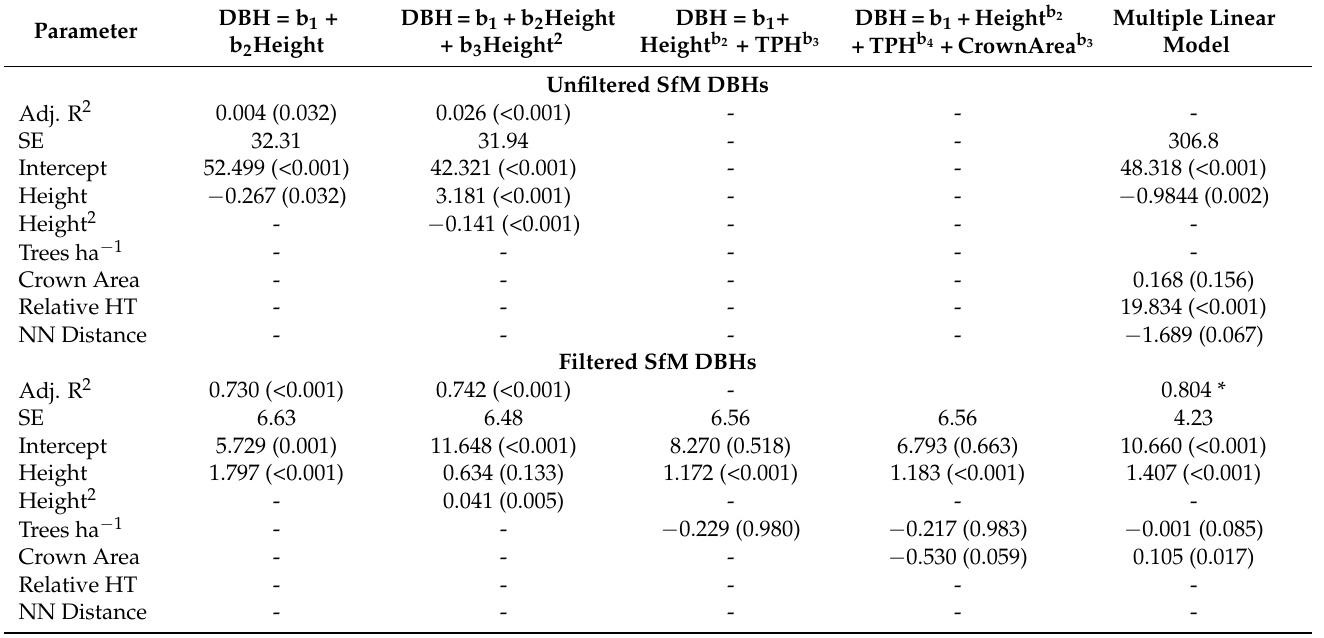
Table 1. Model coefficients (b 1 , b 2 , etc.) for the five parametric model forms fit to the SfM DBHs before and after filtering as the dependent variable. Values in parentheses are p values.